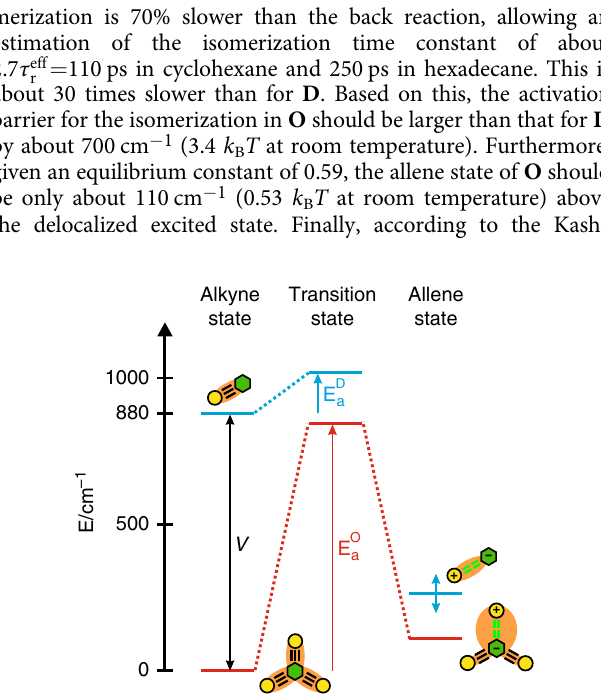
Fig. 6 Tentative energy-level scheme for the isomerization of D and O in non-polar solvents. Green hexagon represents the triazine electron acceptor, yellow circles are the electron donors and orange shading is the electronic excitation. The allene state is a charge-separated state. Only the difference between the activation energies E a D − E a O can be estimated, but their absolute values are unknown, as is the relative energy of the allene state of D .